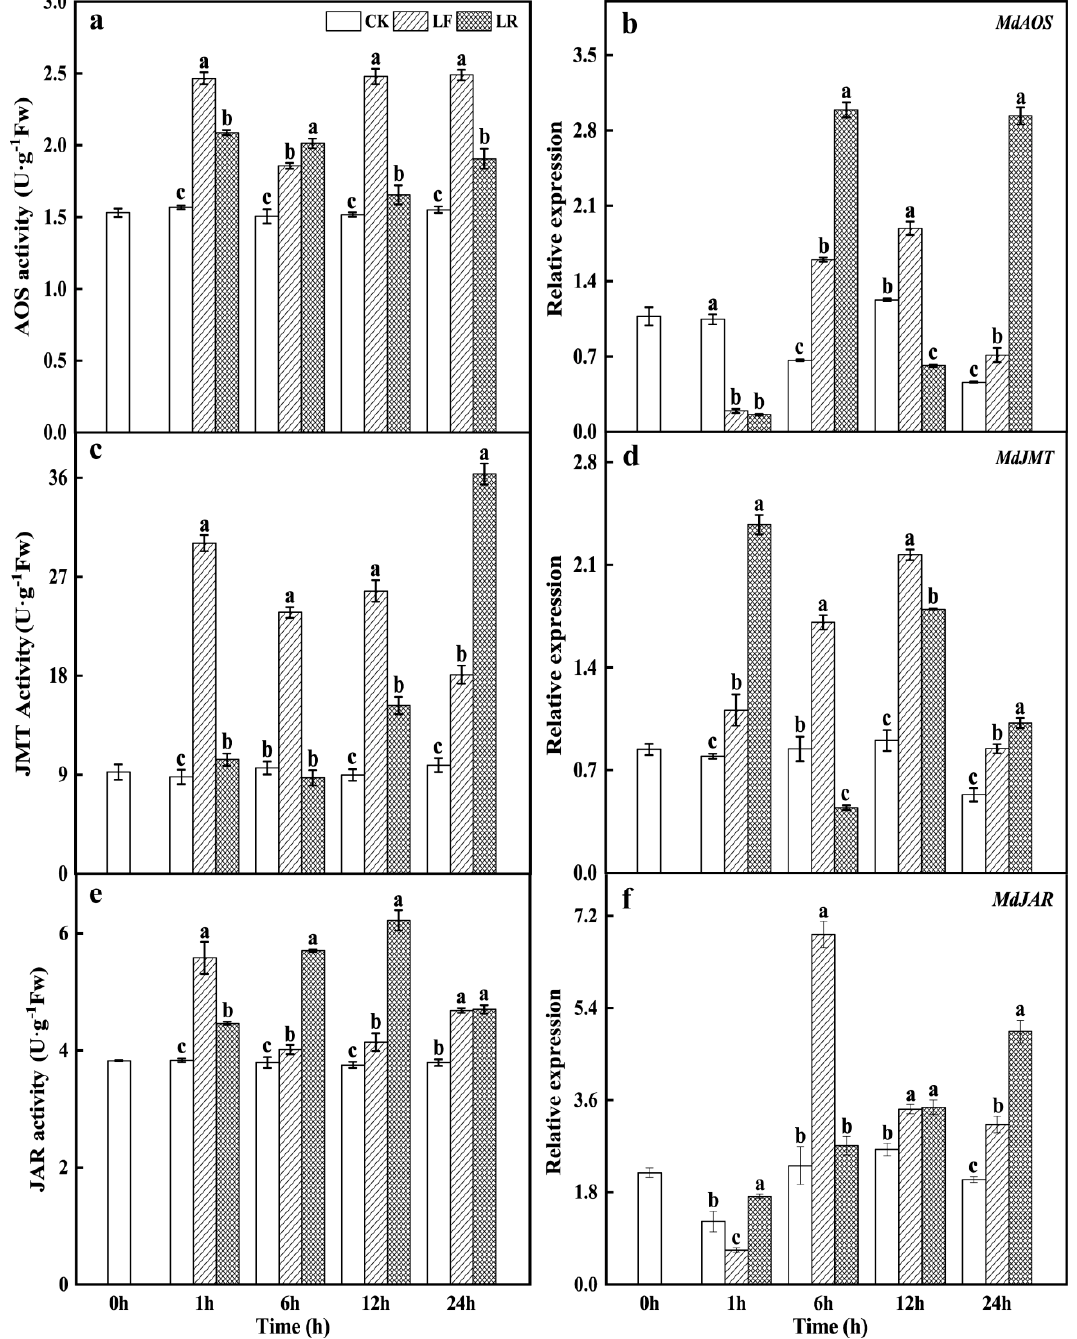
Figure 2. Effects of leaf removal on allene oxide synthase (AOS) activity ( a ), AOS expression ( b ), jasmonic acid carboxyl methyltransferase (JMT) activity ( c ), JMT expression ( d ), jasmonate–resistant 1 (JAR) activity ( e ), and JAR expression ( f ) in the roots of M. baccata under suboptimal low root– zone temperatures. Means (±SE) of three replicates per treatment at each time point independently. Different lowercase letters on the bars indicate significant differences between treatments.